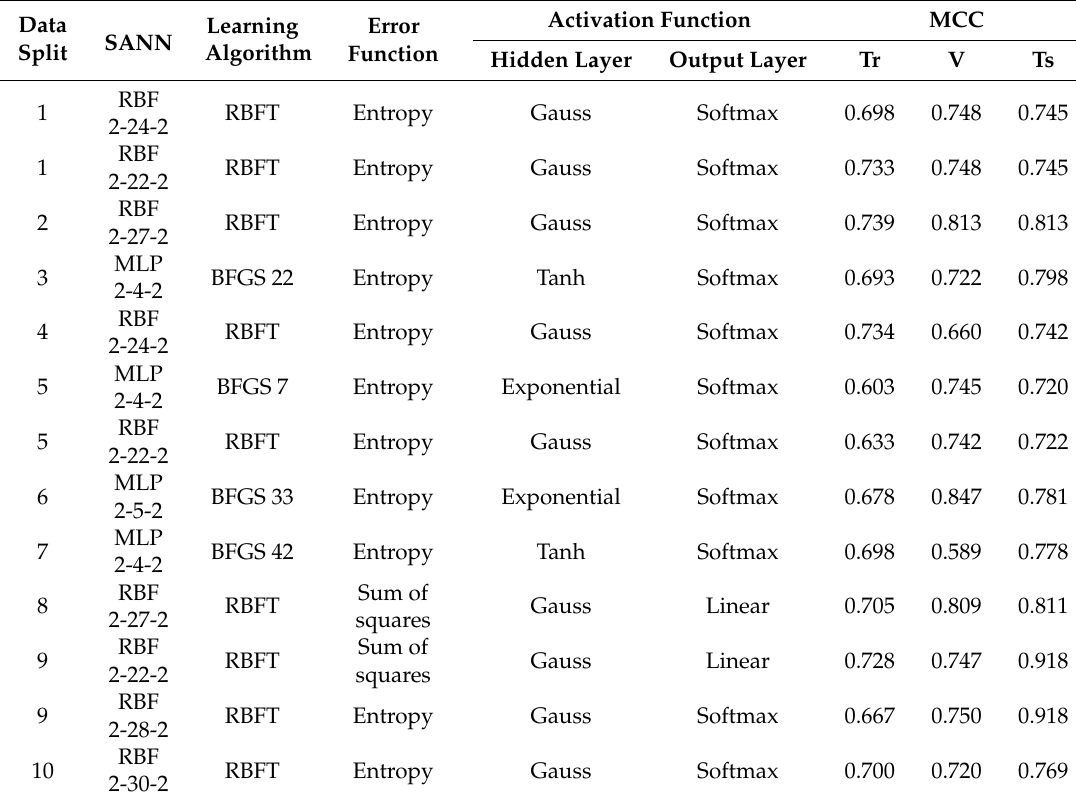
Table 3. The selected details of SANNs developed employing maxHBint3 and SpMax8_Bhs descriptors. The models were generated using ten di ff erent dataset splits (Tr, V, and Ts denote the training, validation, and test sets